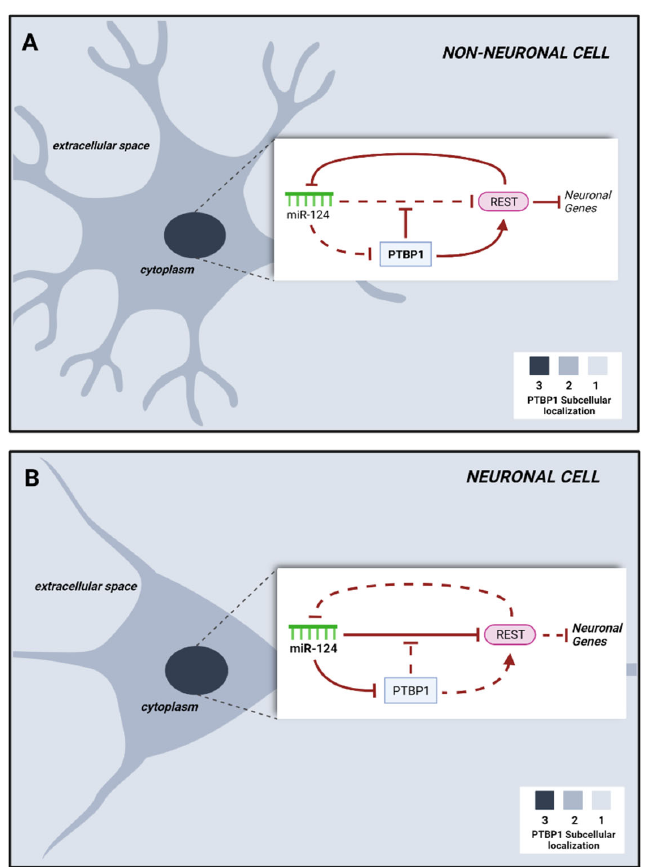
Figure 1. Schematic representation of PTB regulation in mouse non-neuronal ( A ) and neuronal cells ( B ) as described in [17]. In non-neuronal cells, the expression of PTB guarantees the activity of the REST complex in silencing neuronal genes. In neuronal cells, miR-124 upregulation blocks both PTB and the REST complex, allowing the expression of neuronal genes.